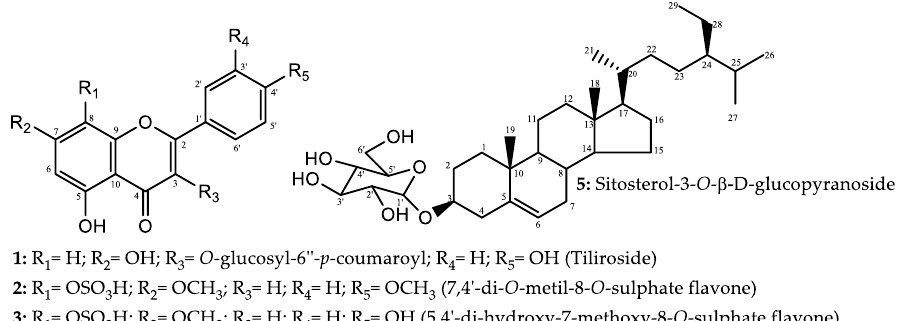
Figure 3. Compounds isolated from H. velutina considered potentially active against A. aegypti larvae after analysis of the applicability domain.